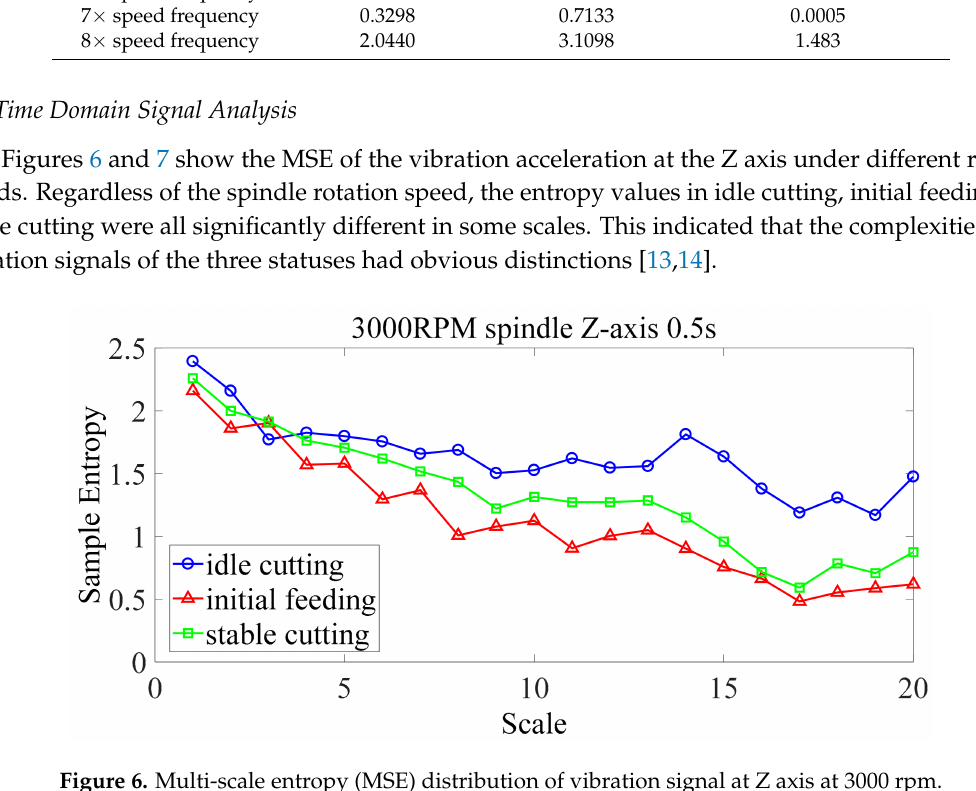
Figure 6. Multi-scale entropy (MSE) distribution of vibration signal at Z axis at 3000